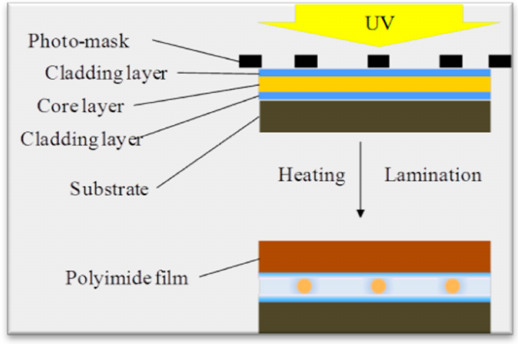
Figure 3. Graded index waveguide fabrication.